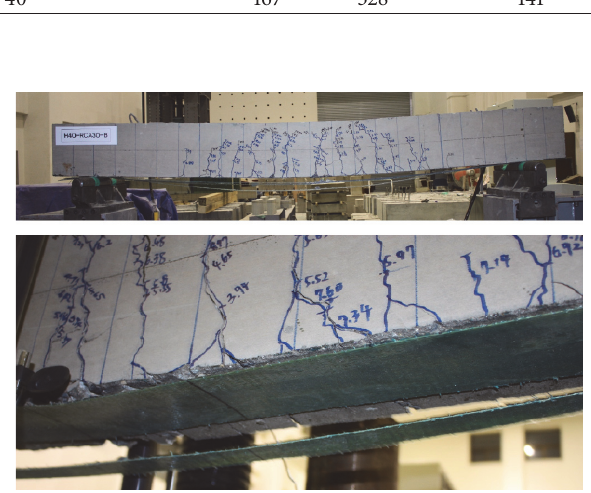
Figure 11: Specimen failure pattern (H40-RCA30-BS).